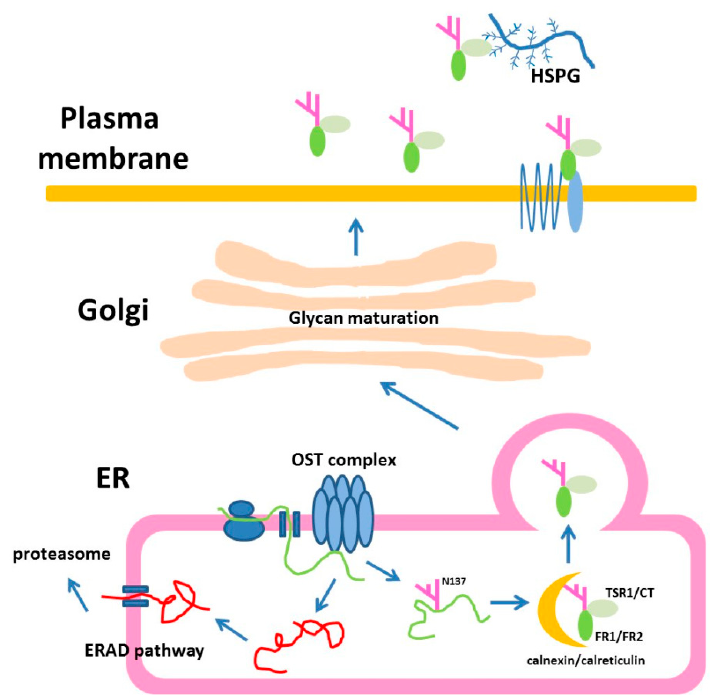
Figure 11. Model for N-glycosylation of Rspo1 in cells. Rspo1 is N-glycosylated at N137, a site near C-terminus of FR2, through oligosaccharyltransferase (OST) complex. Alternatively, this N-glycosylation site can be replaced with the position homologous to N160 in Rspo2 (Q163N/L165T Rspo1), a site near the N-terminus of TSR1. N-glycan of Rspo1 is further trimmed through glucose removal by α -glucosidase. The trimmed Rspo1 then becomes a ligand for ER lectins, calreticulin and calnexin. After the assisted folding with lectins, the Rspo1 becomes properly folded in the ER. Correctly folded N-glycosylated Rspo1 are packaged for transport to the Golgi. After translocation to the Golgi , the oligosaccharide chains are further processed. Unglycosylated mutants N137Q Rspo1 is targeted for degradation through an ubiquitin-proteasome dependent mechanism known as ERAD. The mature secreted Rspo1 is composed of complex type of oligosaccharides. Secreted Rspo1 can bind to LGR4/5/6 and ZNRF3/Rnf43 receptors complex to potentiate Wnt signal through CRD domain (FR1/FR2). Alternatively, their TSR1 and CT domains can provide affinity towards heparan sulfate proteoglycan ( HSPG ).